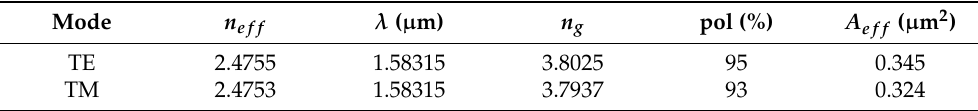
Table 2. Mode analysis